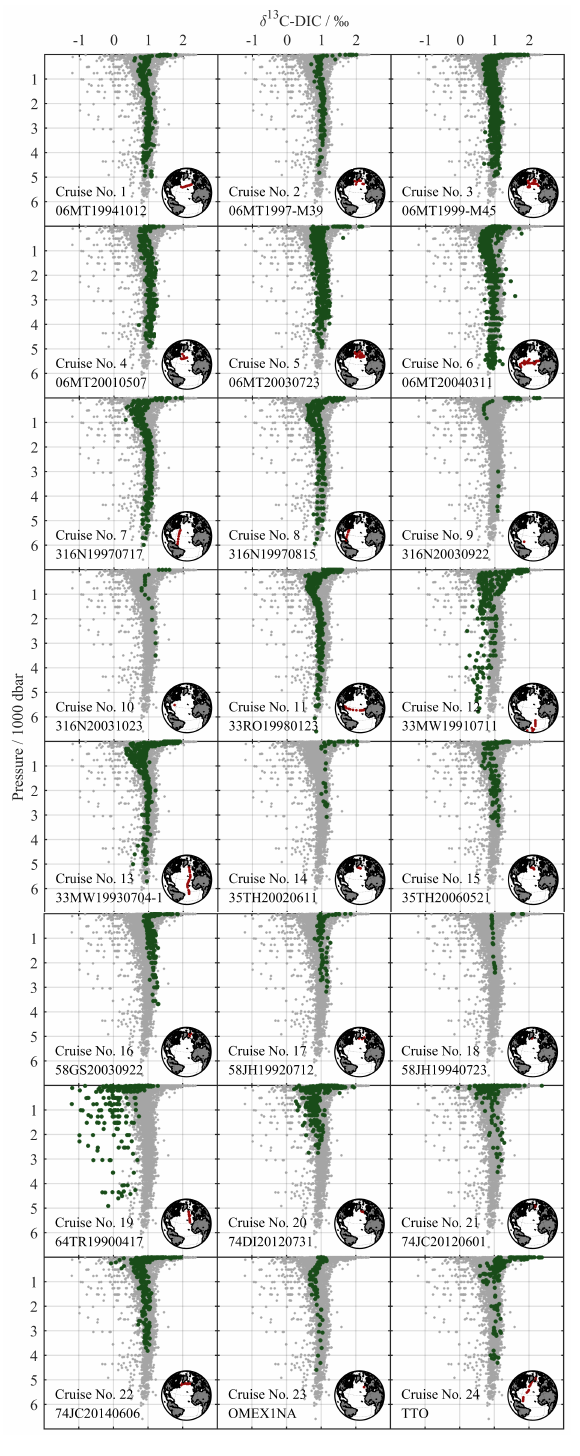
Figure 4. Adjusted δ 13 C-DIC profiles and locations of each cruise. The green profiles represent the data of the specific cruise, whereas the gray dots show all profiles in the dataset.